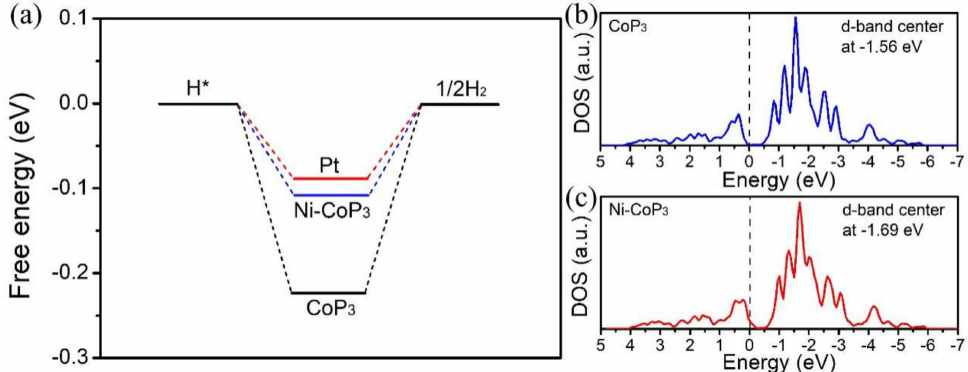
Figure 6. DFT calculations. ( a ) Calculated free-energy diagram of Pt, Ni-CoP 3 , and CoP 3 . ( b , c ) Calcu- lated DOS curves for CoP 3 and Ni-CoP 3 , respectively.